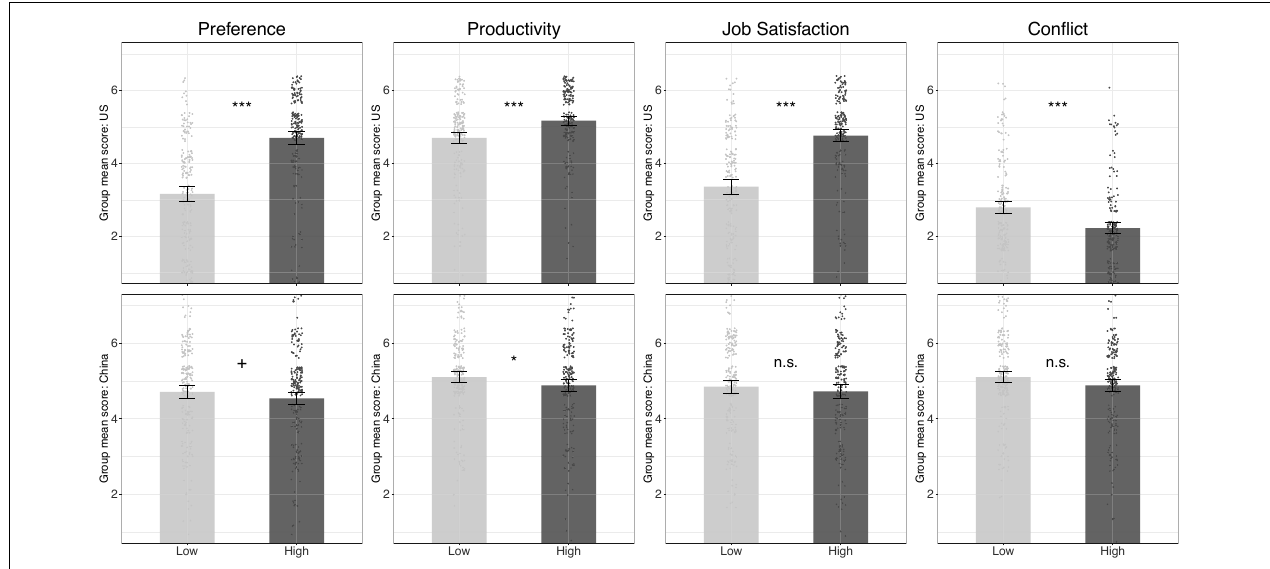
FIGURE 1 | Study 3 results. The figure represents cultural group means for the self-reported Preference for each workplace and the perceived outcomes of employee Productivity , Job Satisfaction , and workplace Conflict comparing the Low-Participation versus High-Participation condition for both the United States (the first row) and the Chinese full-time employees (the second row). Each dot in the background represents an employee’s actual rating on the corresponding construct. Error bars represent 95% confidence intervals. * p < 0.05, ** p < 0.01, *** p < 0.001, n.s. denotes non-significance with alpha at the conventional 0.05 level.